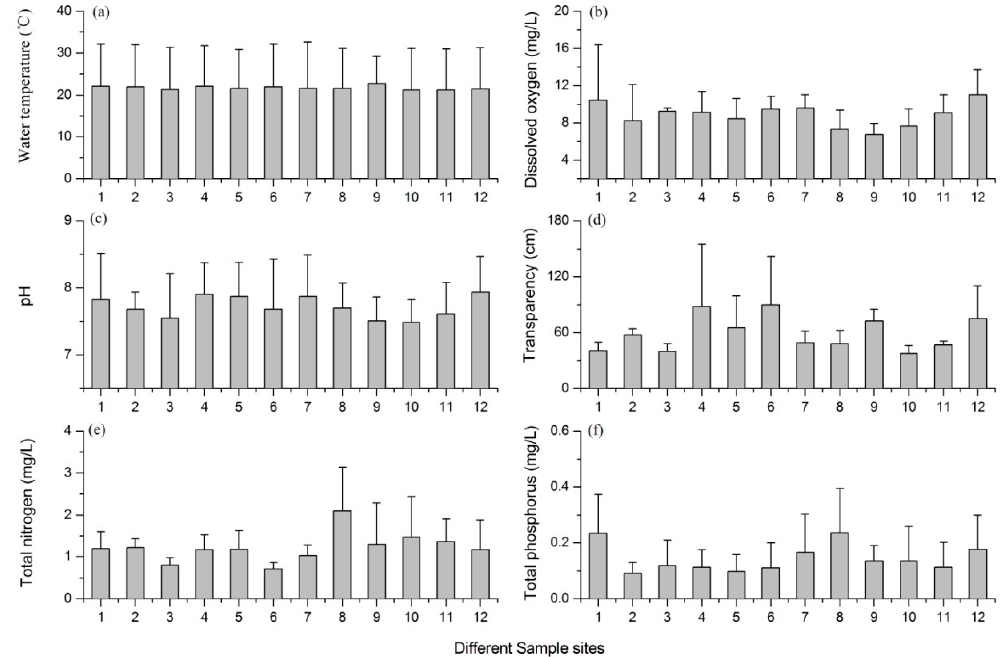
Figure 2. Mean values of the main environmental factors at different sites; the error bars are the standard deviations of data from different seasons. ( a ) Water temperature; ( b ) dissolved oxygen; ( c ) pH; ( d ) water transparency; ( e ) total nitrogen; and ( f ) total phosphorus.